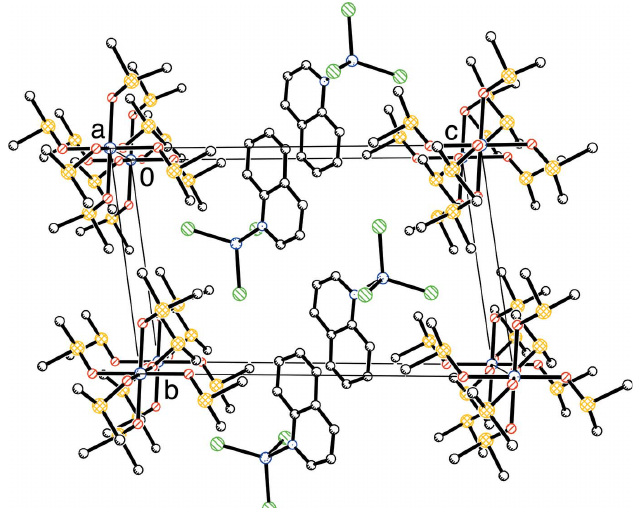
Figure 2 The packing of [Co II (Me 2 SO) 6 ][Co II Cl 3 quinoline] 2 . H atoms have been omitted for